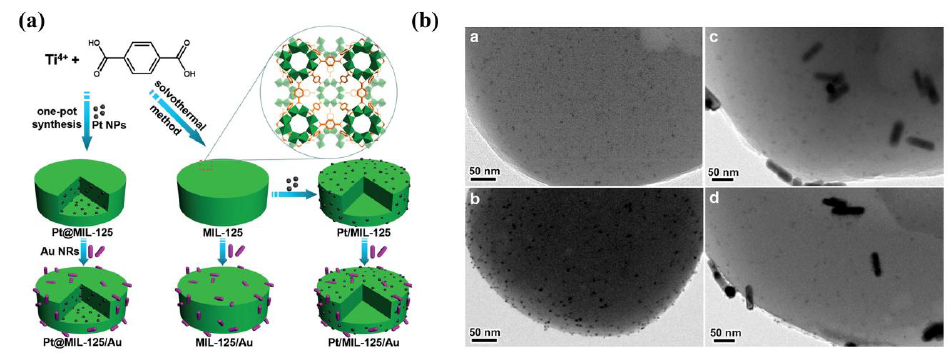
Figure 2. ( a ) Schematic illustration showing the synthesis of Pt@MIL-125/Au and the corresponding Pt/MIL-125/Au and MIL-125/Au analogues. ( b ) Typical TEM images of (a) Pt@MIL-125, (b) Pt/MIL-125, (c) Pt@MIL-125/Au, and (d) Pt/MIL-125/Au. Reproduced with permission from Reference [46].